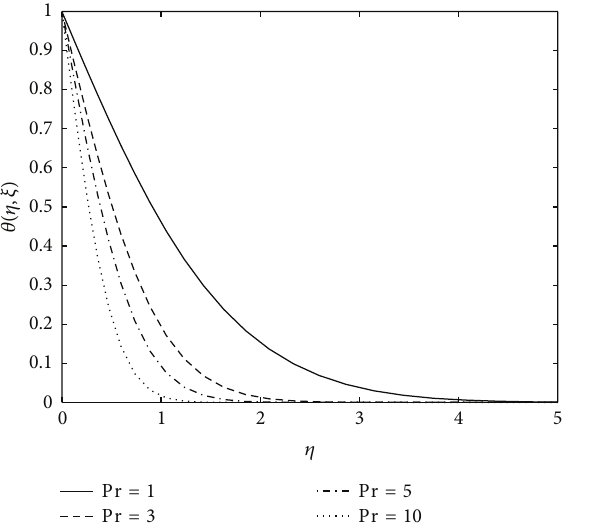
Figure 3: Effect of the Prandtl number on the temperature profile.